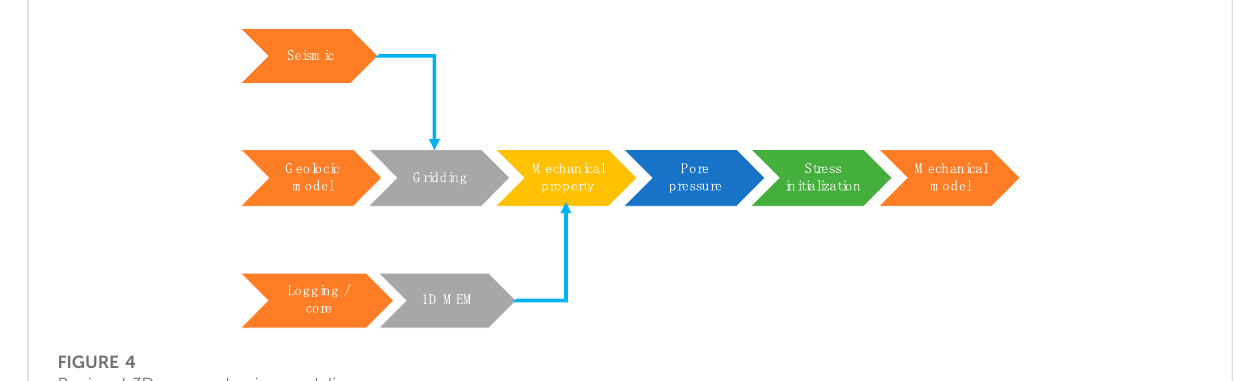
FIGURE 4 Regional 3D geomechanics modeling process.